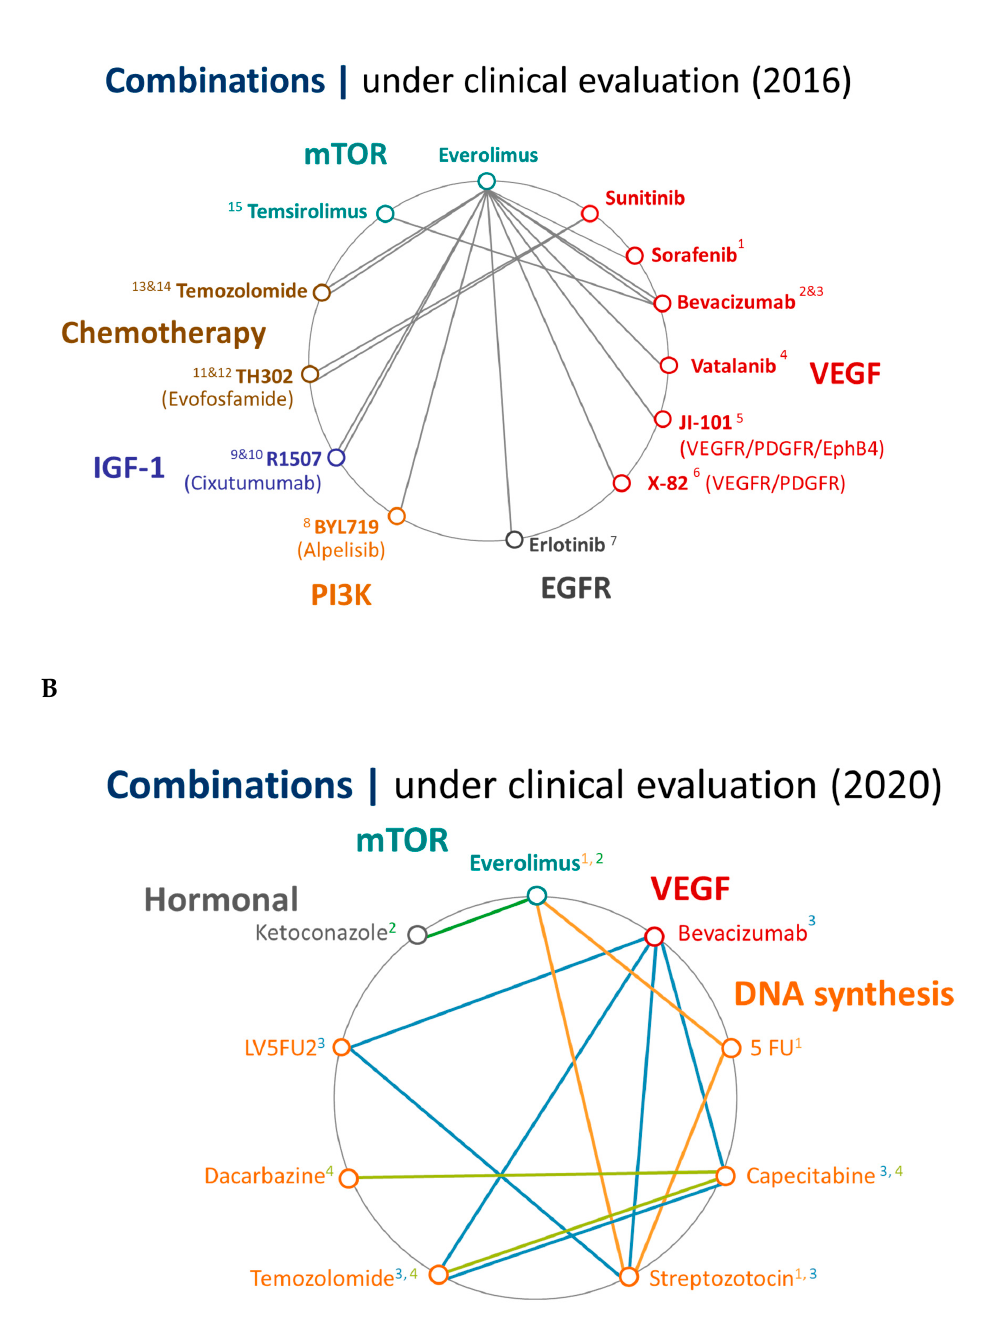
Figure 5. Ongoing combination trials in patients with PanNETs. Figure 5B: Combinations | under clinical evaluation (2020). Figure 5A: Combinations | under clinical evaluation (2016). ( A ) 1 NTC00942682 (Phase I), 2 NCT00607113 (Phase II), 3 NCT01229943 (randomised Phase II), 4 NCT00655655 (Phase